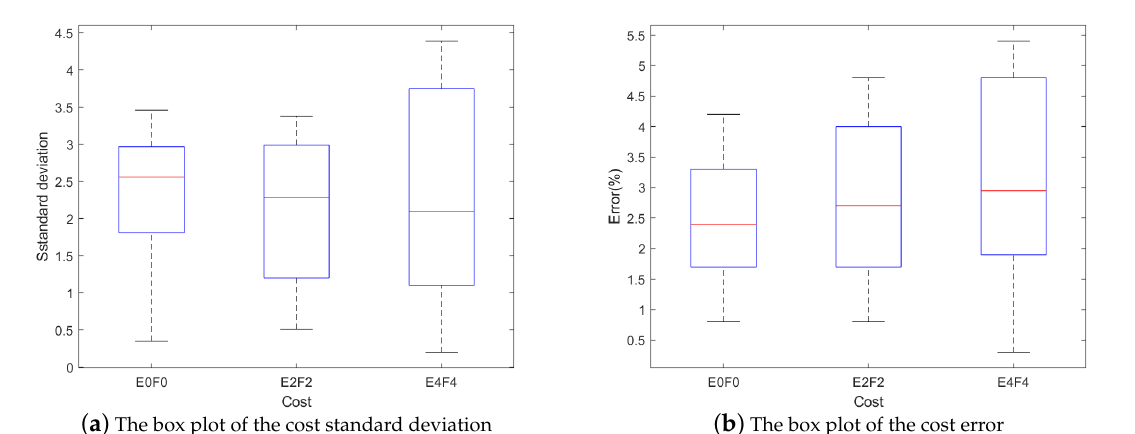
Figure 5. The graphics of the comparison